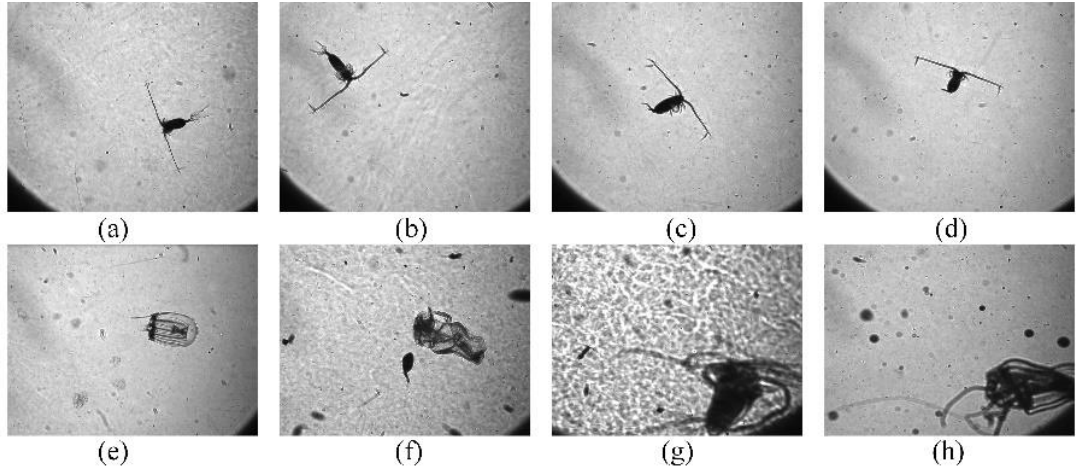
Figure 1. ( a – d ): Copepods of different positions and attitudes; ( e – h ): jellyfishes of different positions and attitudes.